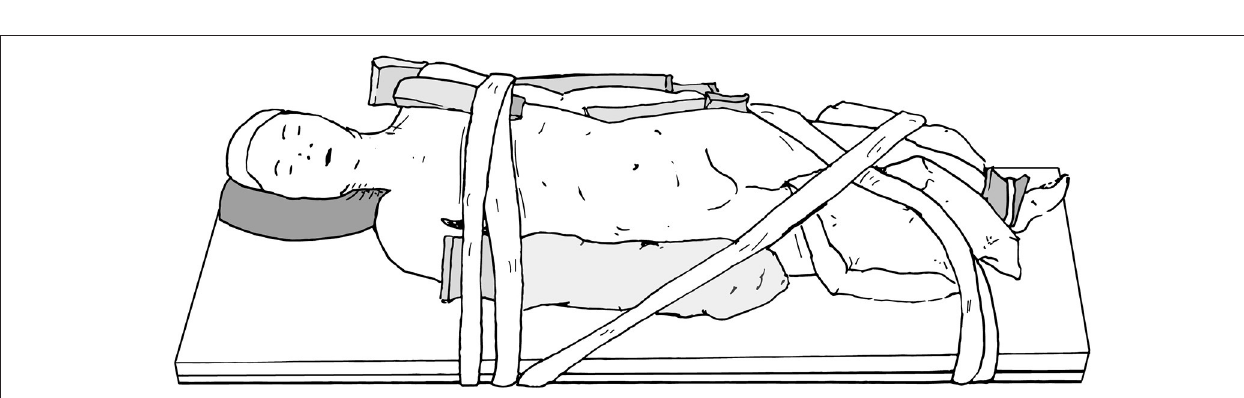
Frontiers in Pediatrics |